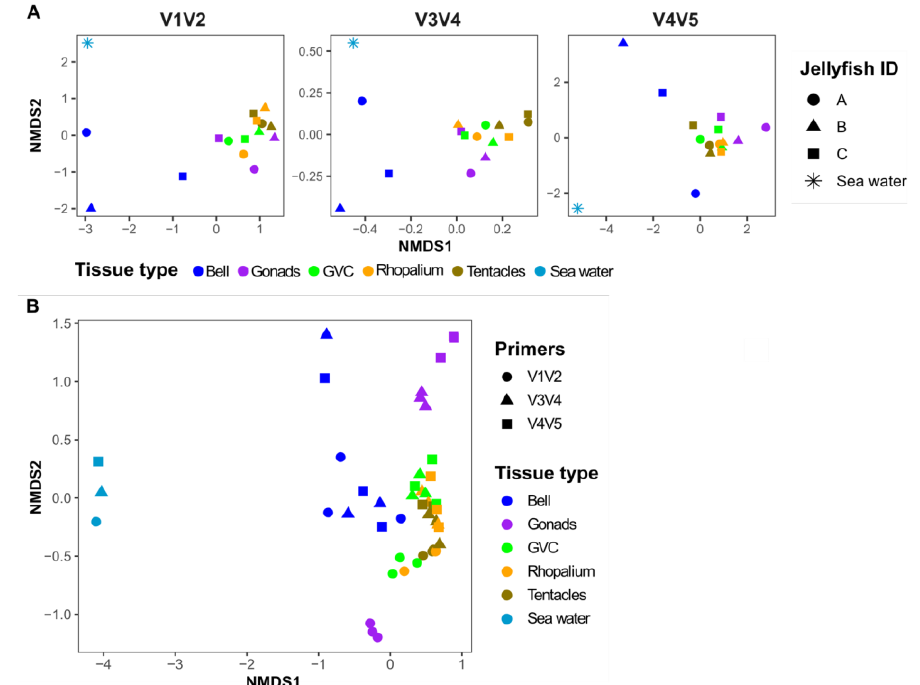
Figure 4. Non-metric multidimensional scaling (NMDS) of the bacterial community composition in different jellyfish and tissues obtained with different primers. ( A ) ASVs-based NMDS of the V1V2 primer (stress 0.07), V3V4 primer (stress 0.08), and V4V5 primer (stress 0.07). ( B ) Taxonomy-based NMDS analysis. Bacterial community composition of both ASVs and taxonomy-based NMDS are based on the Bray–Curtis dissimilarity (stress 0.10).